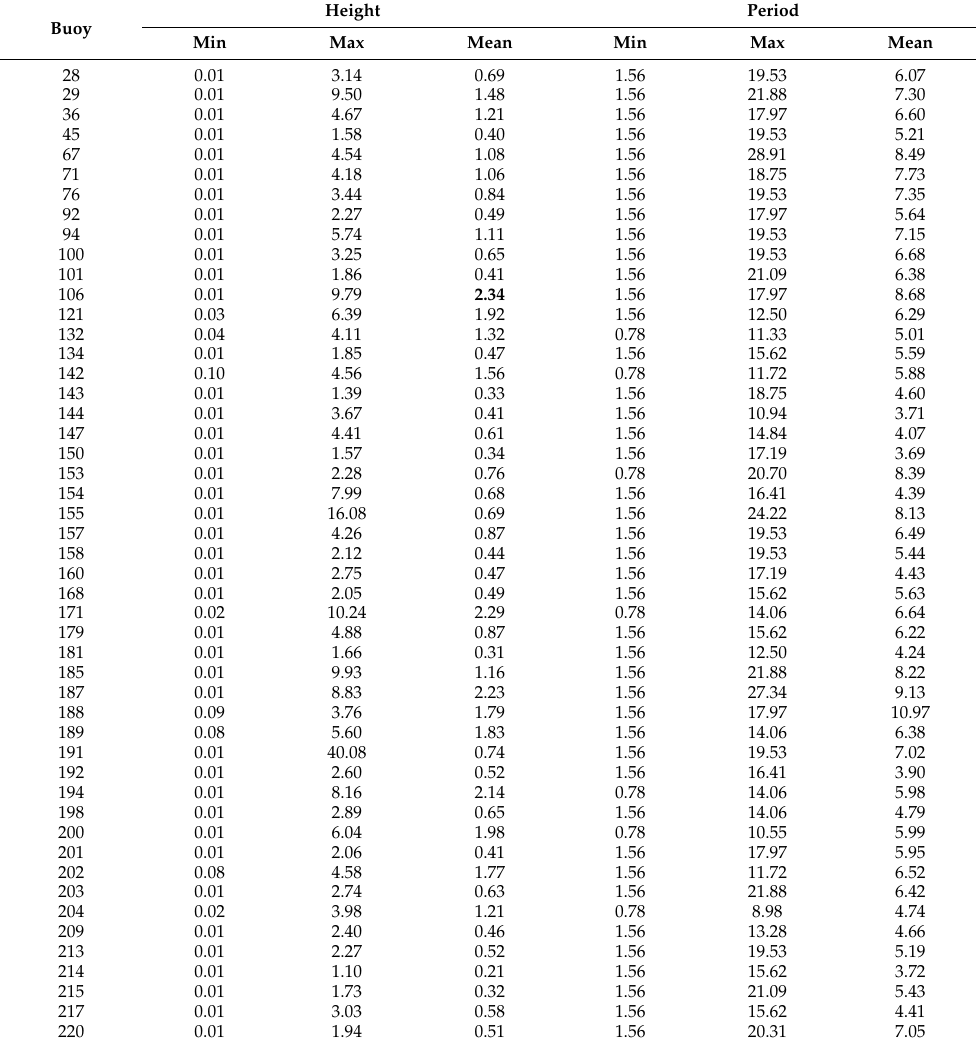
Table 5. For each of the 63 buoys of positive length, minimum, maximum, and mean wave height and period of the studied time